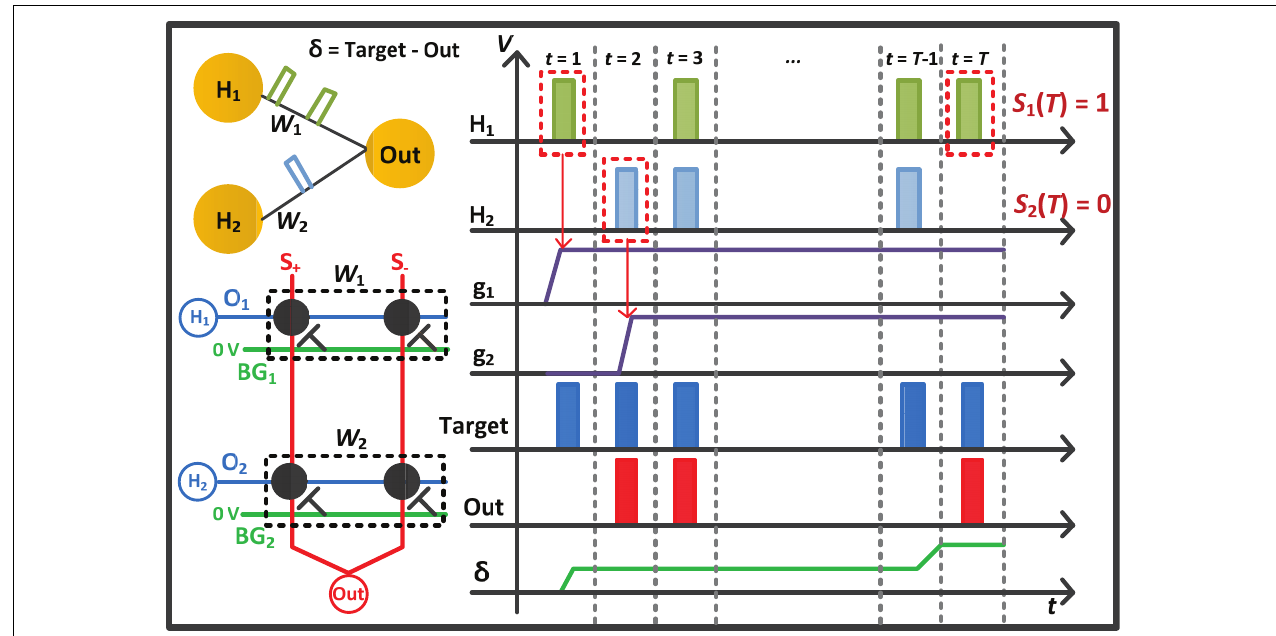
FIGURE 3 | Conceptual diagram with a 1-layer network for the forward phase (FP) of the proposed on-chip training scheme. The spikes from previous layers propagate along the O line of the G + and G - array, and the current sum of the array is integrated into the membrane capacitor of the I&F. When the neuron H 1 and H 2 generate a spike, the derivative (g 1 and g 2 ) of the neurons is set to a value of 1.